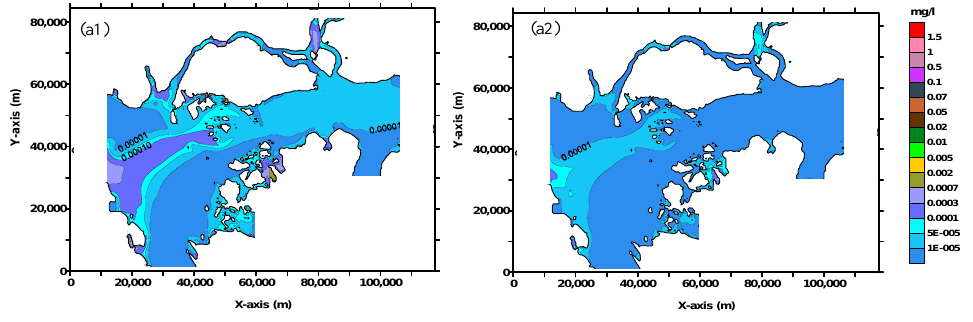
Fig. 9. The absolute change of phytoplankton concentration at surface water from baseline due to the atmospheric wet deposition during (a1) hazy and (a2) non-hazy days.